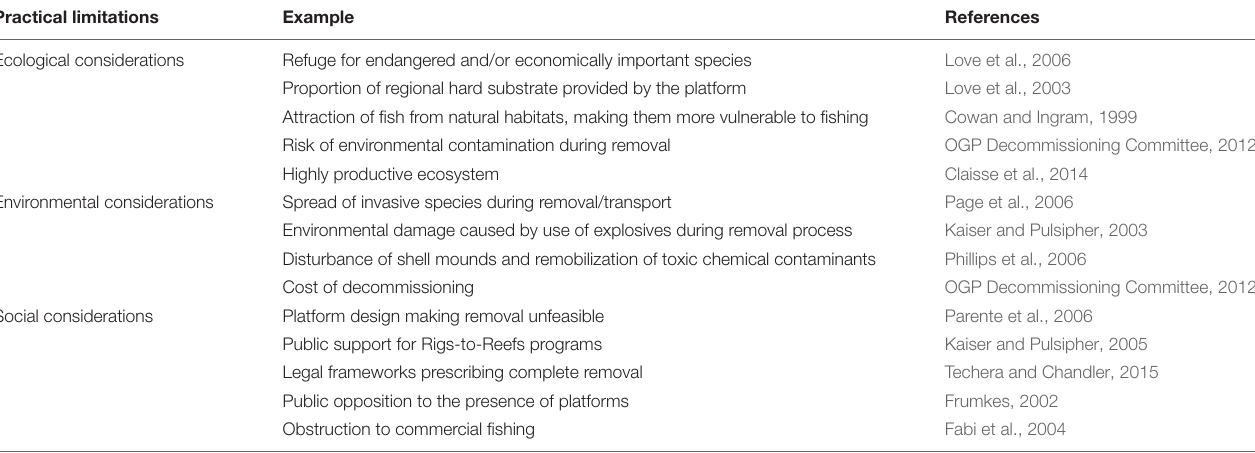
TABLE 1 | Examples from the literature of practical considerations preventing offshore platform sites from being returned to their historical